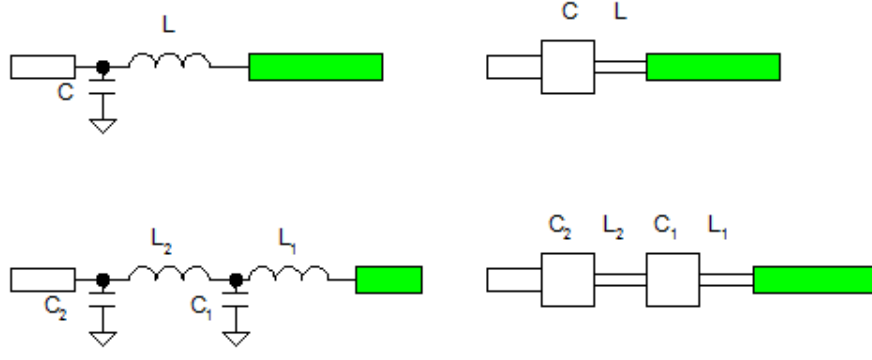
Figure 13. Schematic of the matching circuit of the antenna (top: unipole, simple match, bottom: independent matching in both operating bands).